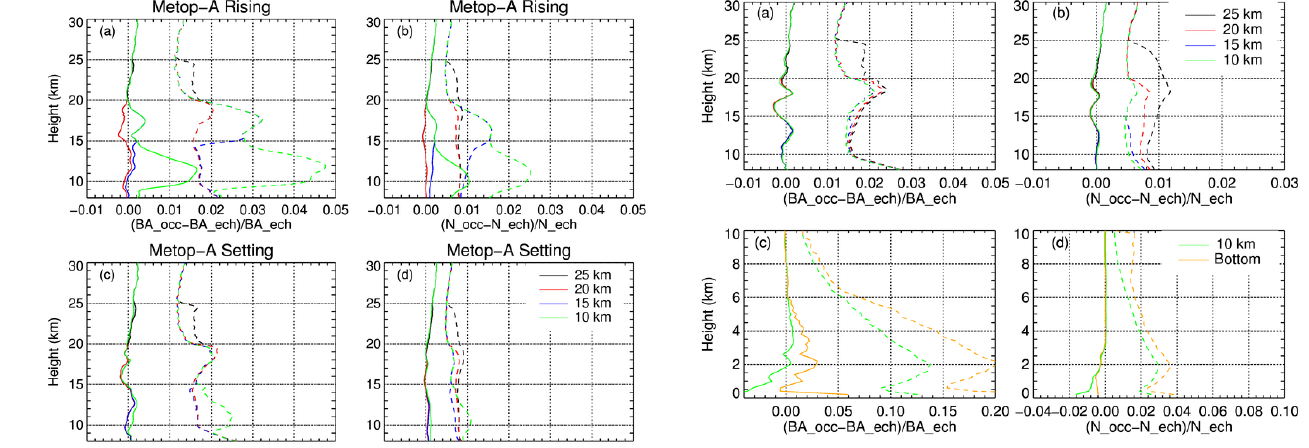
Figure 8. Similar to Fig. 5, except for the COSMIC L2C setting occultations, for all latitudes. Panels (a, b) and (c, d) correspond to different height intervals and different extrapolation (transition) heights (colors indicated in